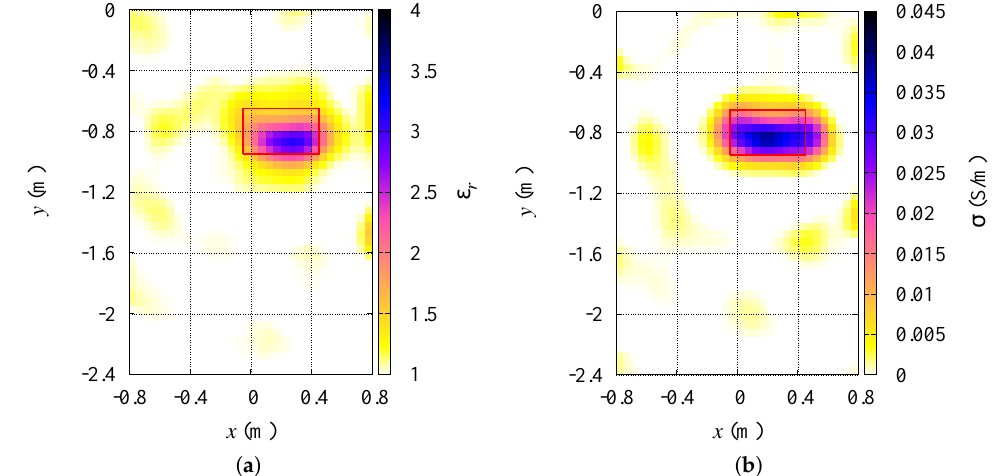
Figure 4. Aligned sensors. Reconstructed distributions of the ( a ) relative dielectric permittivity, and ( b ) electric conductivity of the region under